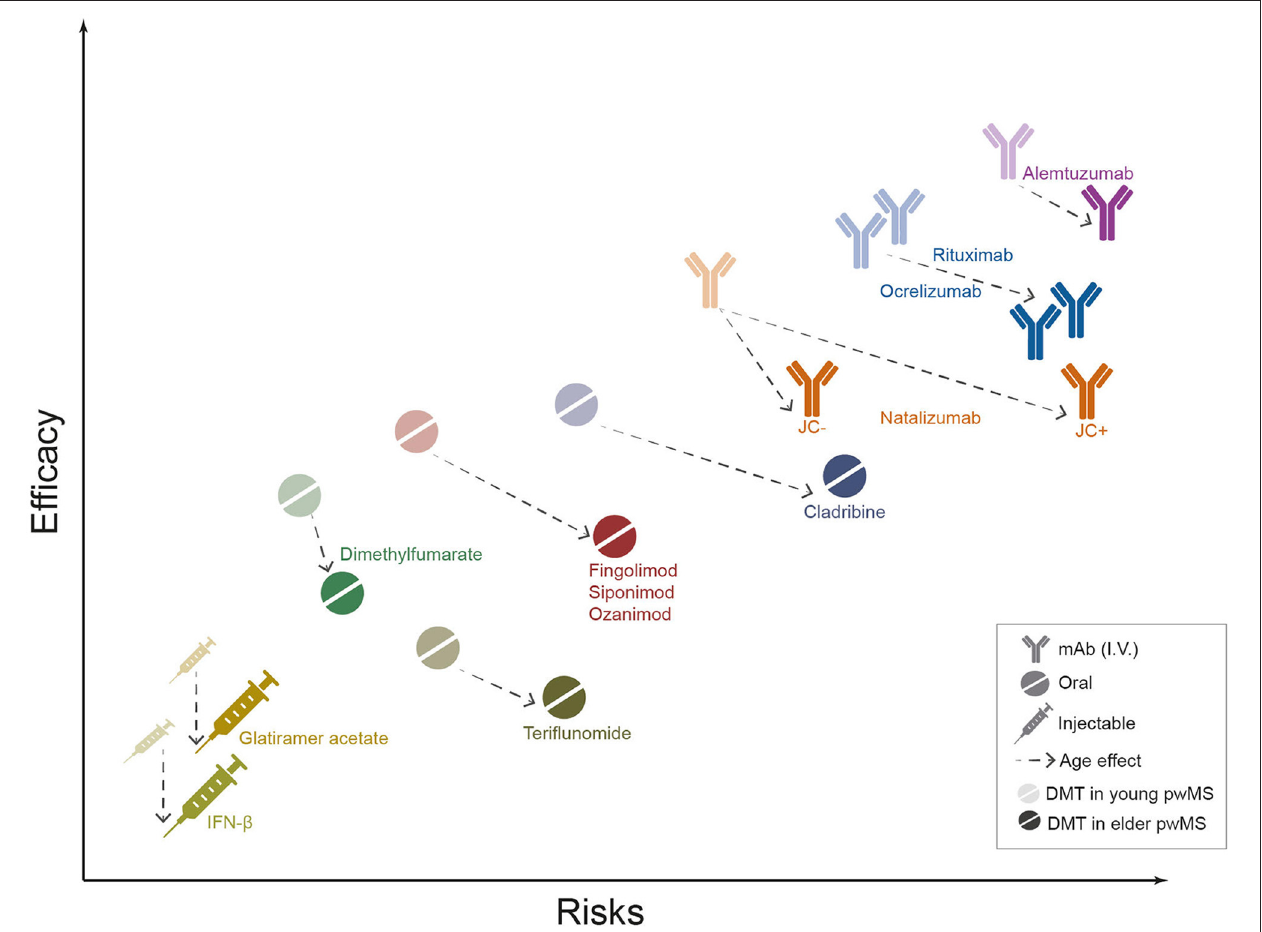
FIGURE 1 | Safety and efficacy of MS DMTs in elder people with MS (pwMS). The graph shows the position of currently used MS drugs in terms of efficacy ( y axis ) and safety (expressed as growing risk burden, x axis ). Semi-transparent icons represent DMTs effects in younger pwMS, while solid icons display the estimated effects in elderly. Dotted arrows illustrate the estimated effect of age on DMT safety and efficacy. The drugs’ profiles are based on the authors’ judgment, educed from the interpretation of currently available literature data. mAbs, monoclonal antibodies; I.V., intravenous administration; IFN-B, Interferon β .